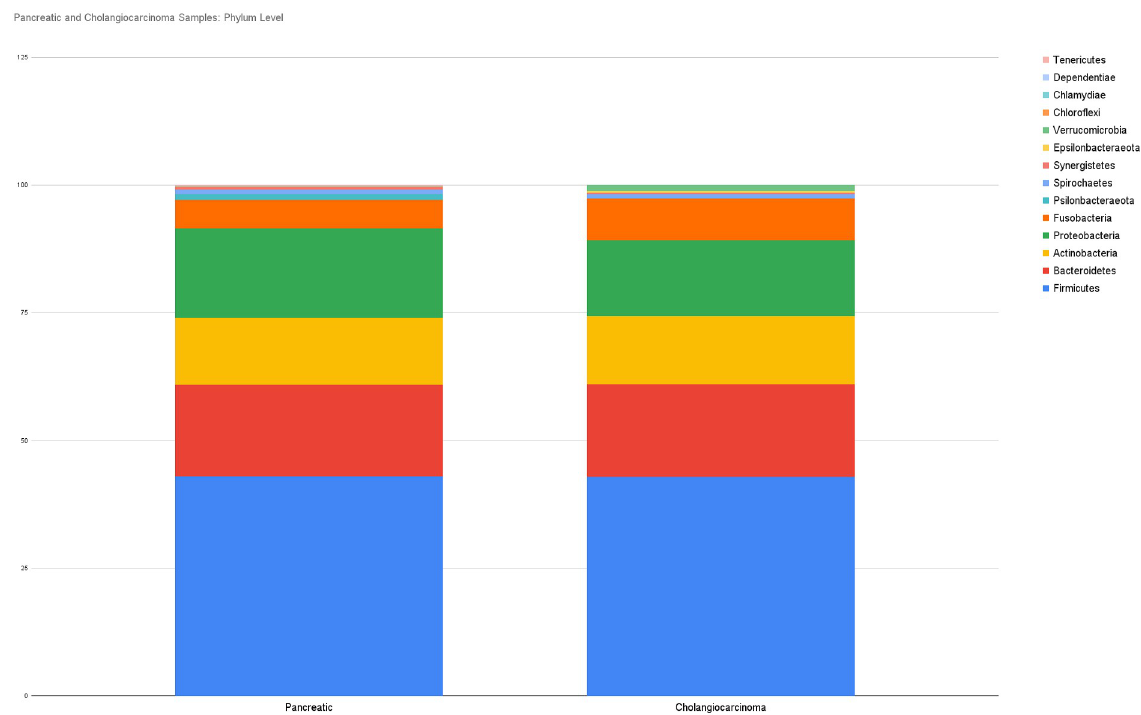
Fig 5. Relative abundance of dominant phyla in bile from patients with pancreatic cancer and cholangiocarcinoma.